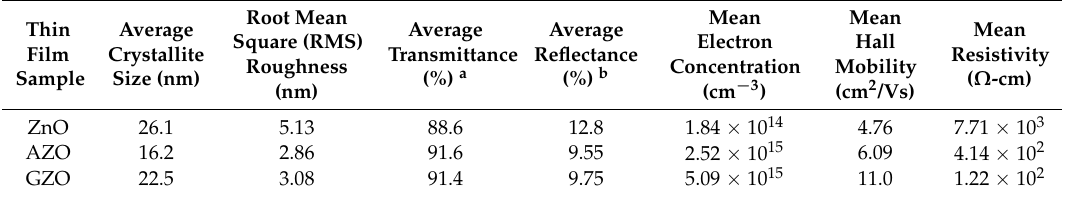
Table 1. Structural, optical, and electrical properties of sol-gel-derived ZnO, AZO, and GZO thin films.